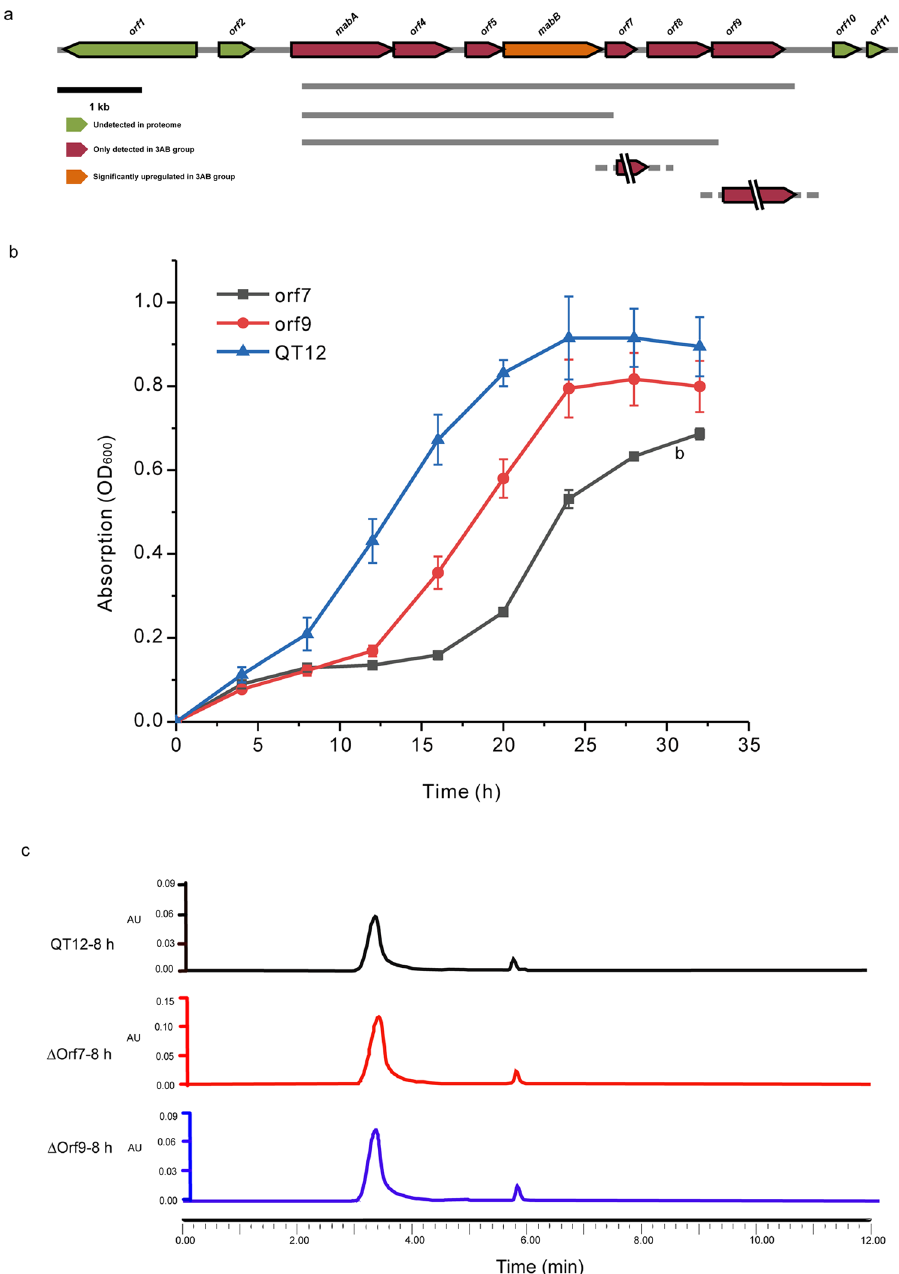
Figure 5. Effect of mab cluster on degradation of 3AB and determination of growth metabolic pathway of △ orf7 and △ orf9 mutant strains. ( a ) Physical map of the DNA fragment containing mab cluster involved in 3AB degradation in Comamonas sp. QT12. The arrows indicates the location, direction and size of the transcription of the orfs. ( b ) The growth of wild-type strain QT12, △ orf7 and △ orf9 mutant strains on 3AB group. ( c ) The metabolites of the wild-type strain QT12, △ orf7 and △ orf 9 mutant strain products were detected by